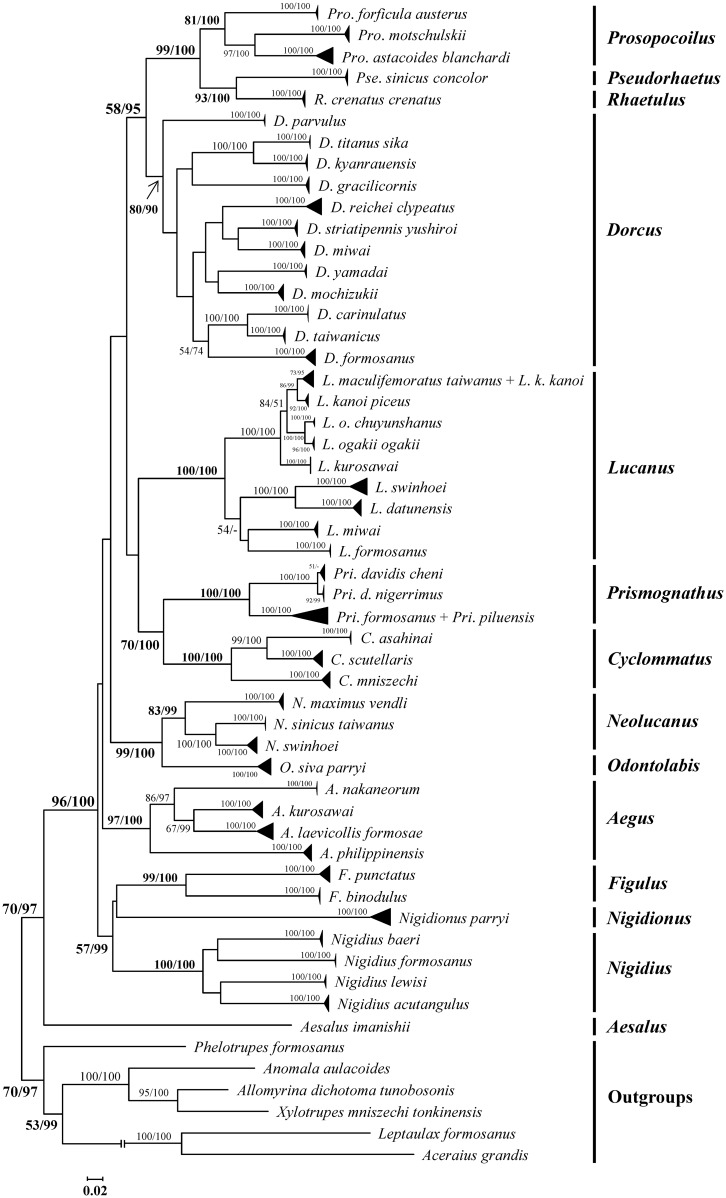
Phylogenetic inferences based on COI+16S rDNA+28S rDNA using maximum likelihood (ML).Both bootstrapping values of ML (left) and posterior probabilities of Bayesian inference (BI) (right) >50% are shown at nodes.